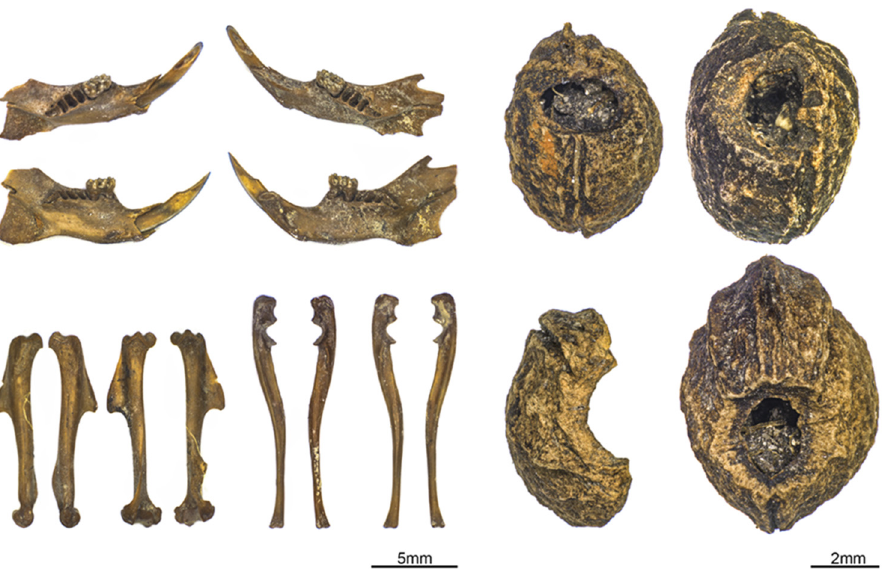
Figure 4. ( Left ) Selection of Apodemus cf. sylvaticus remains from well 990 and 994. ( Right ) Black- thorn fruit stones ( Prunus spinosa ) with mice gnaw marks from well 250. Photographs: Raül Soteras. Three naturally occurring species of the genus Apodemus ( A. sylvaticus , A. flavicollis,